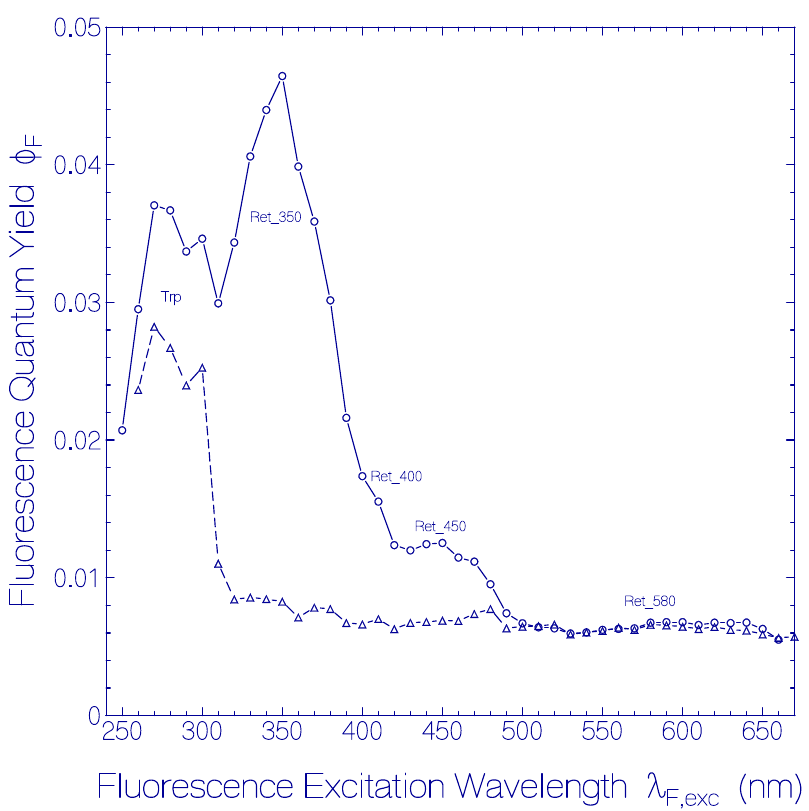
Figure 3. Dependence of the total fluorescence quantum yield φ F on the fluorescence excitation wavelength λ F,exc for QuasAr1 in pH 8 Tris buffer. The dashed line connected triangles belong to a fresh thawed sample. The line-connected circles belong to a sample stored at 2.5 ± 0.5 °C in the dark over a period of 80 days.